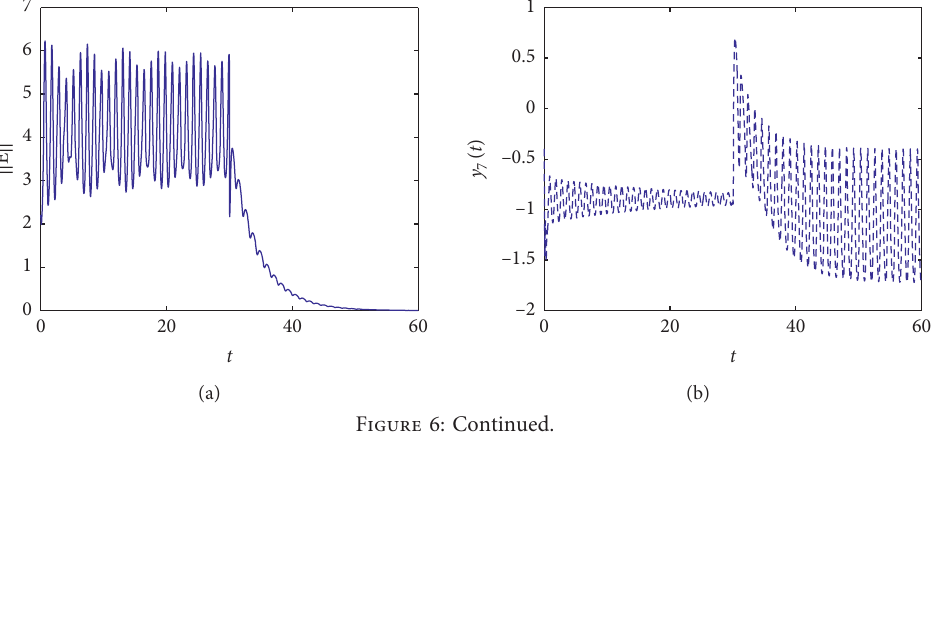
� 24 to a steady state regime. The controller is switched on at time e ( t ) of the slave system vs. time. (c) The phase portrait of the states of the 7 − R e 2 e 1